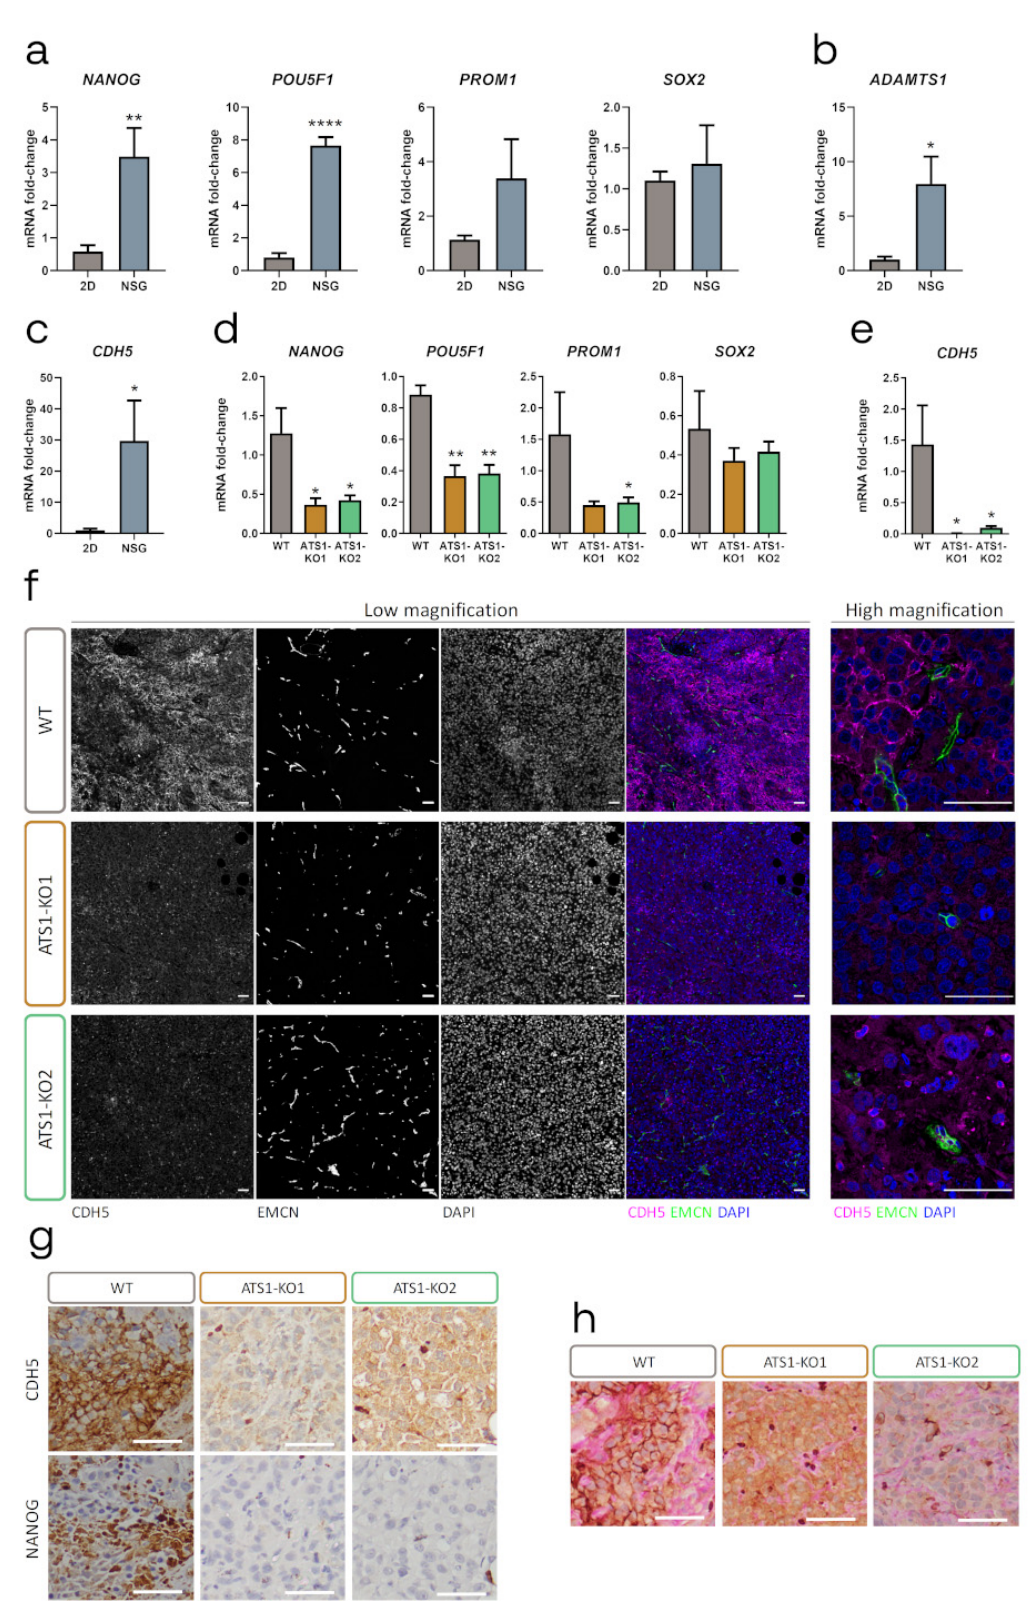
Figure 4. ADAMTS1 inhibition compromises the stemness capacities and endothelial-like phenotype in tumor xenografts. ( a–c ) Graphs representing mRNA fold change expression of NANOG , POU5F1 , PROM1 and SOX2 ( a ), ADAMTS1 ( b ) and CDH5 ( c ), in MUM-2B WT 2D cultured cells and